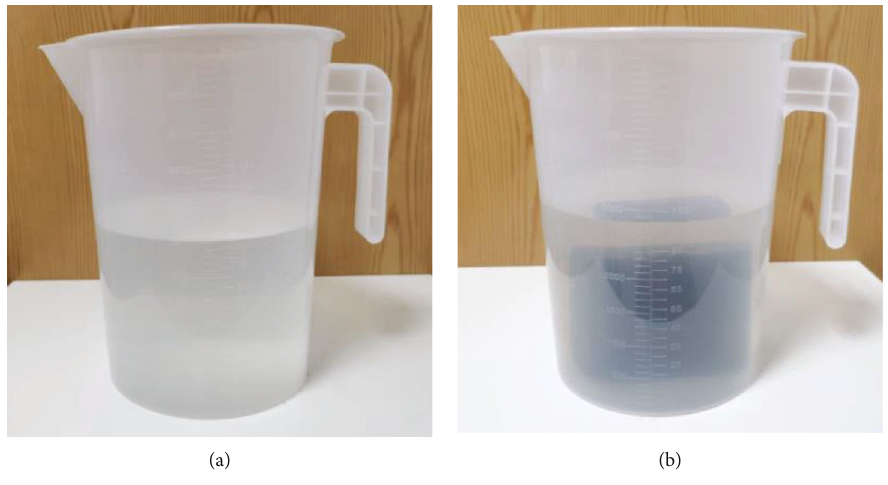
Figure 3: Measuring